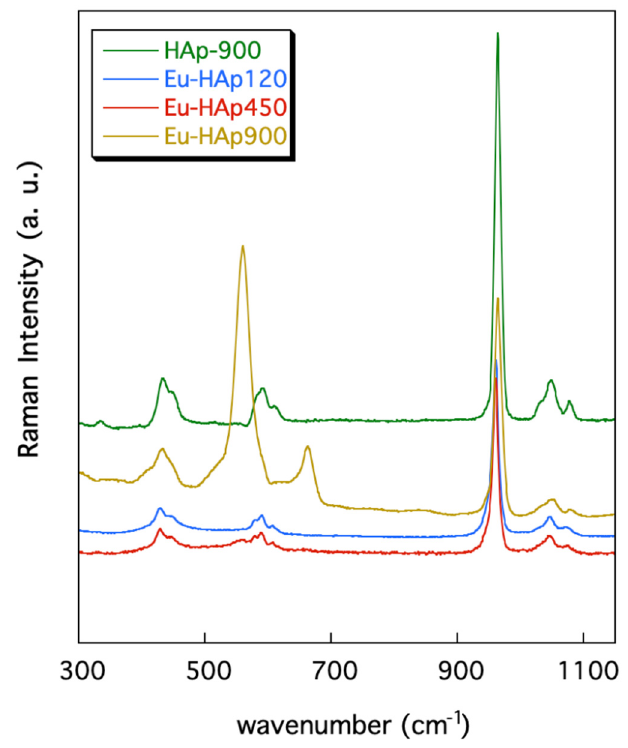
Figure 5. Raman spectra of Eu-doped HAp samples in comparison with undoped HAp. Table 7. Raman spectra and relative assignments for HAp